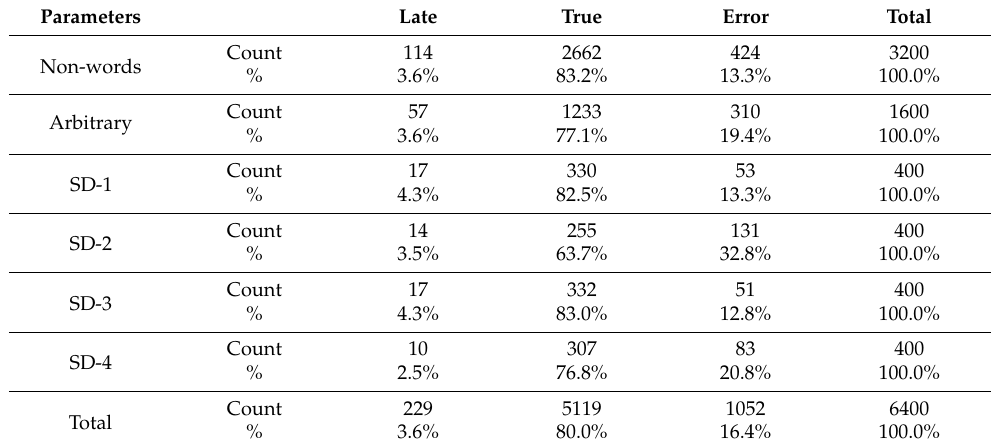
Table 3. Contingency table Parameter*Accuracy for the English-language Sample.